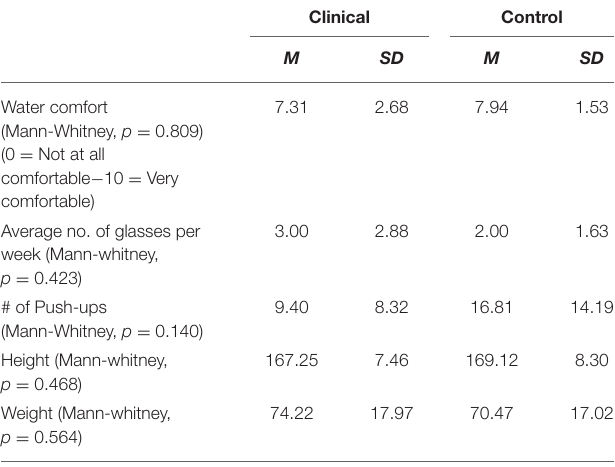
TABLE 2 | Demographic information: continuous variables.